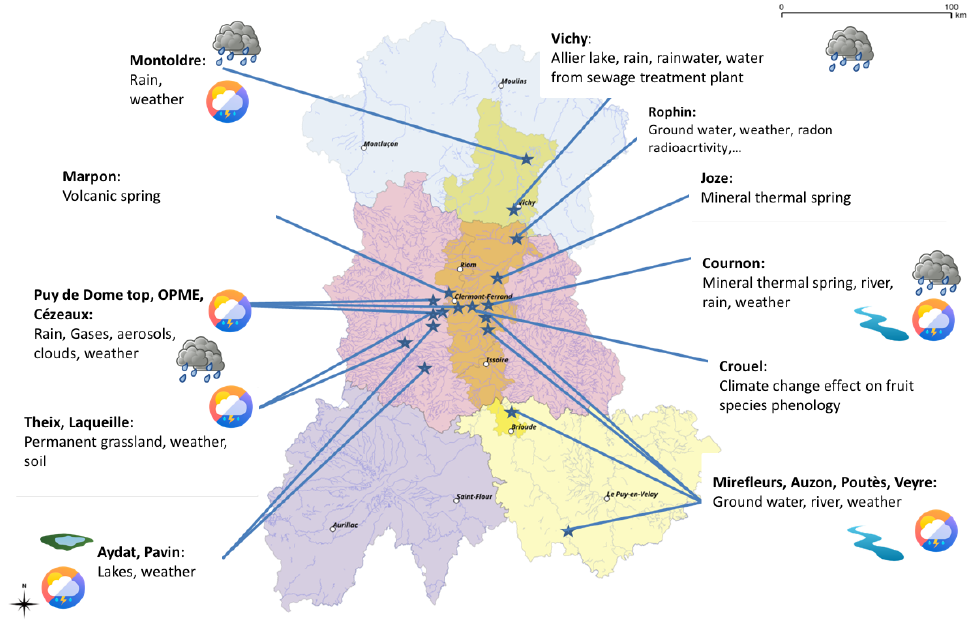
Figure 1. Geographical area and sites covered by the